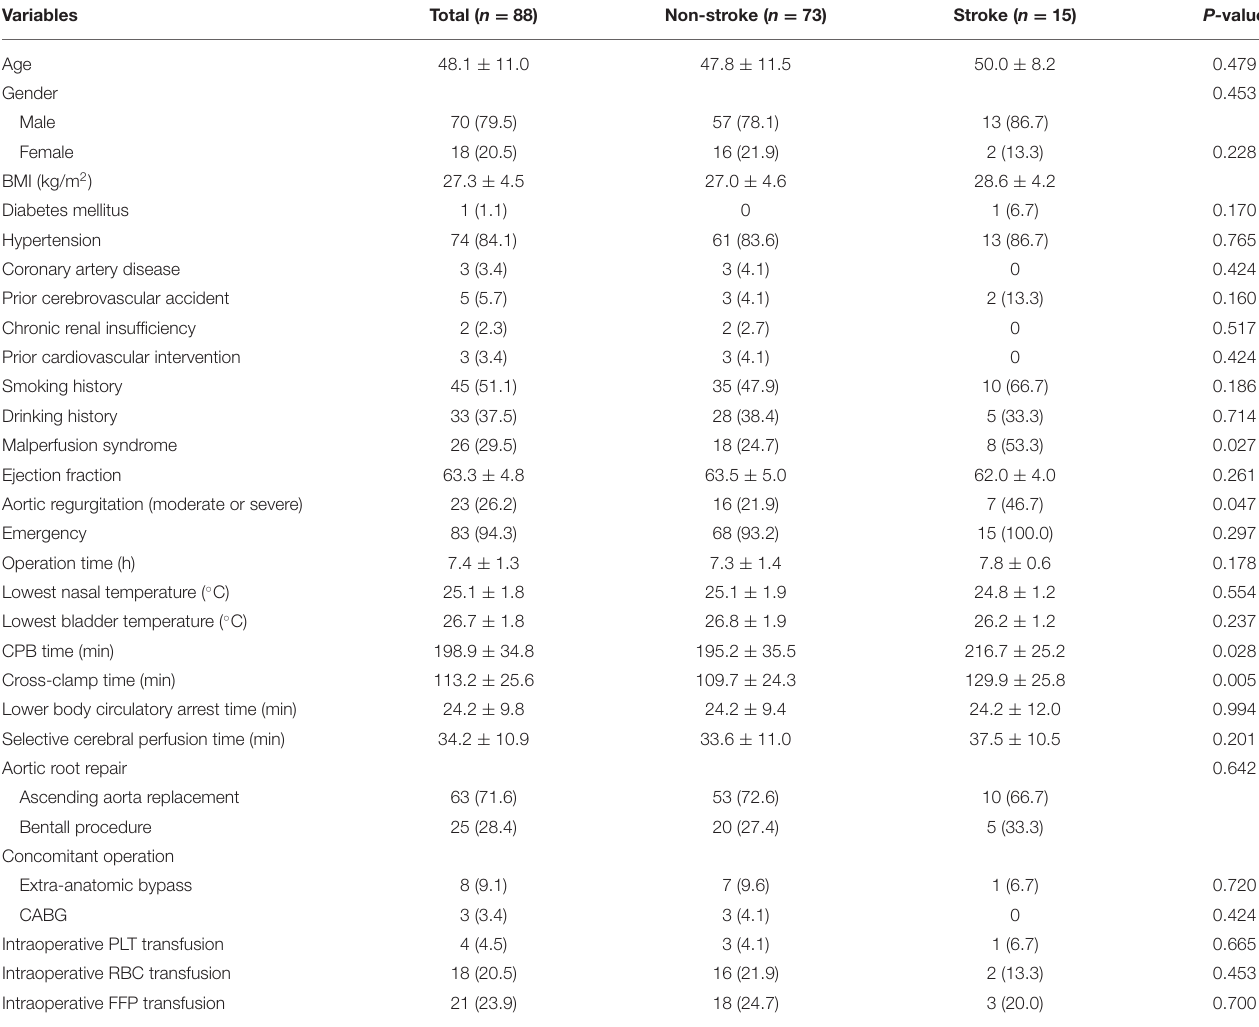
TABLE 1 | Pre-operative and intraoperative characteristics.